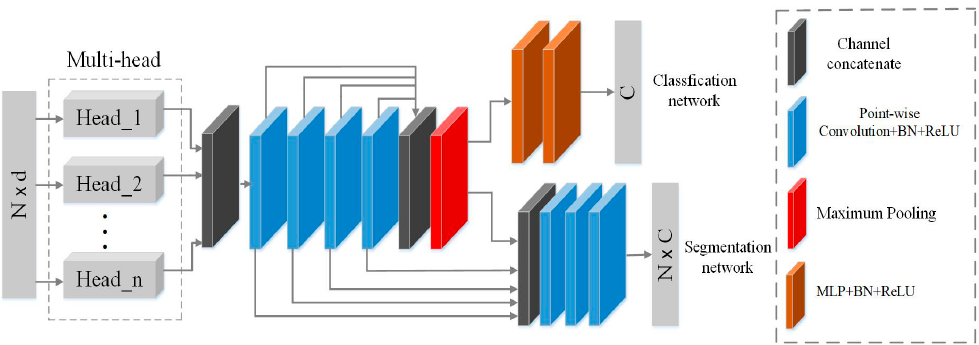
Figure 3. The architecture of the proposed Dynamic neighborhood Network (DNet).